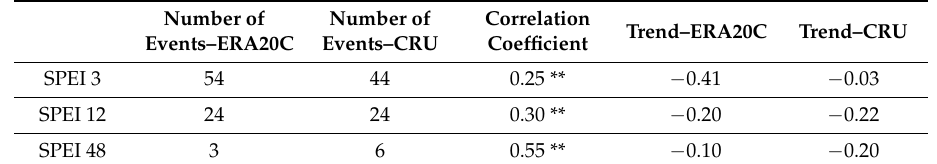
Table 2. Number of events, Spearman correlation coefficient and trend for observation (IAG) and reanalysis (ERA20C) data in the ESP region, from 1901 to 2010. The trend is represented by the slope of the regression line. * indicates the significant trend (according to MK test) or correlation coefficient (according to t-test) at α = 0.1 and ** indicates the significant trend/coefficient at α = 0.05.